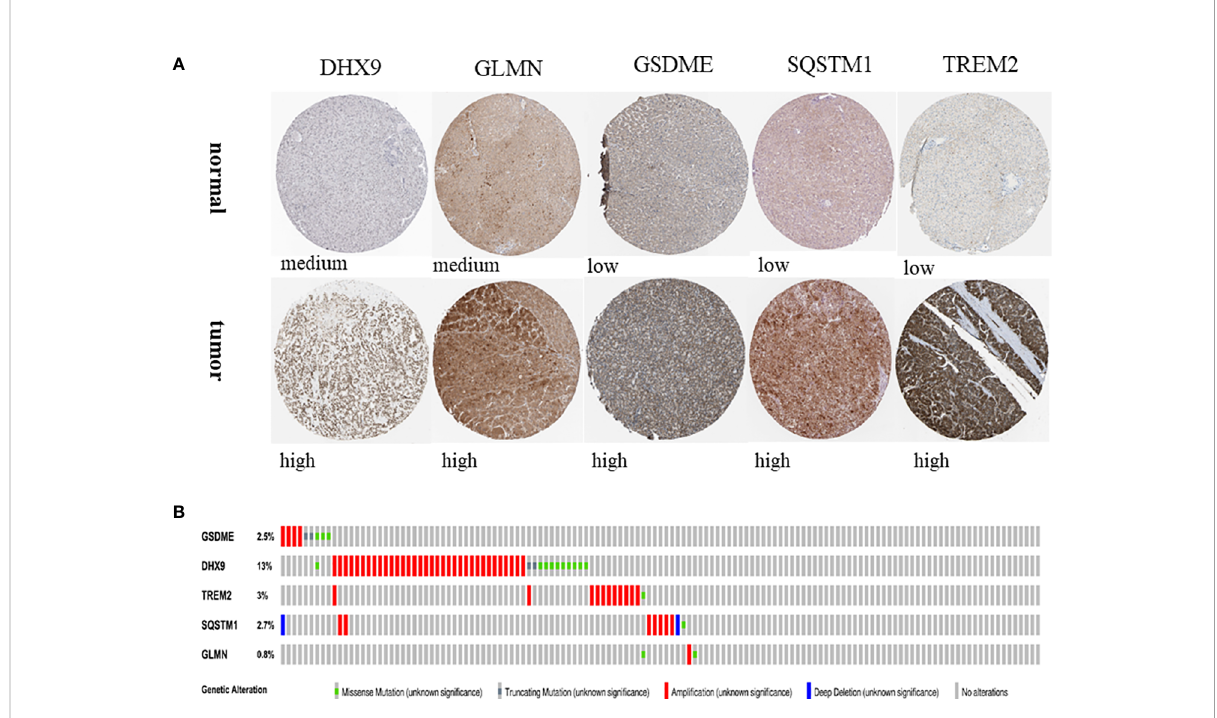
FIGURE 10 Expression and alteration of the fi ve prognosis-related DEGs. (A) The representative protein expression of the fi ve genes in HCC and normal tissue. Data were from the Human Protein Atlas (http://www.proteinatlas.org) online database. (B) The expression change pro fi les of the fi ve genes in TCGA HCC RNA-seq dataset.